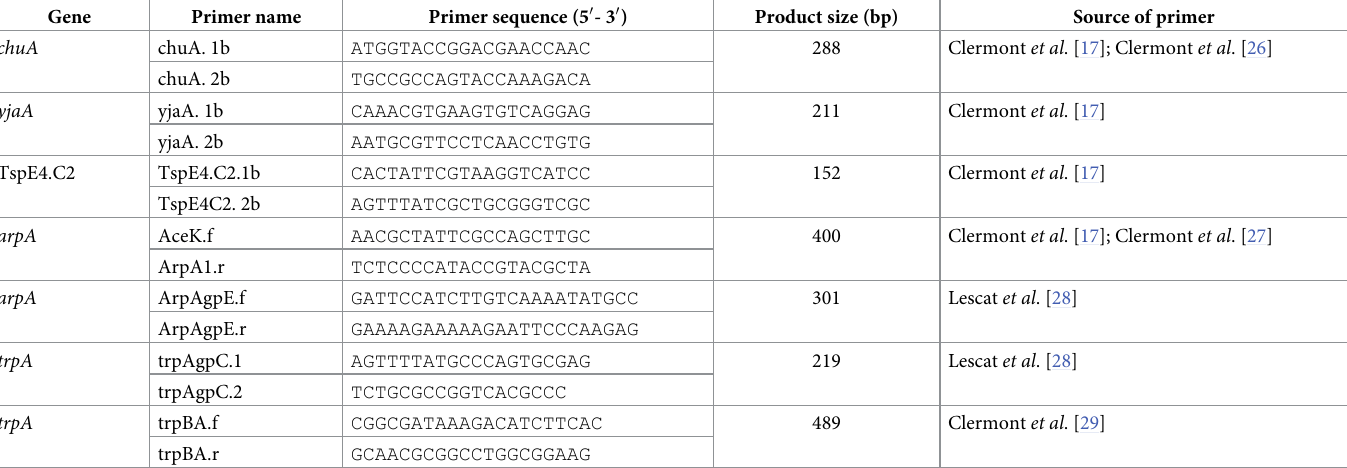
Table 1. Primer’s sequence for detection of E . coli phylogroups.